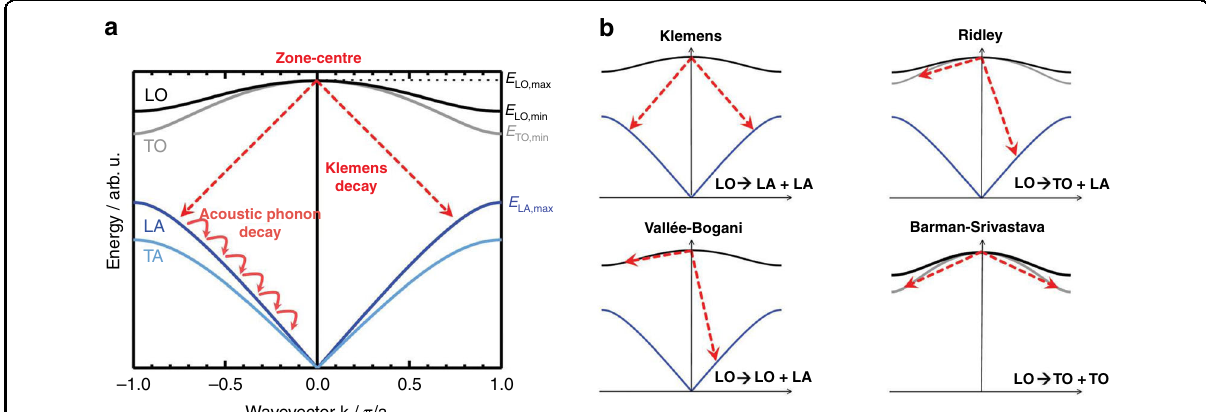
Fig. 6 The dispersion relation for a phonon in the case of diatomic materials in 3D form. a The predominant routes of phonon decay start from their origin center as LO phonons and progressively turn into lower energy acoustic phonons that are responsible for the dissipation of heat. b The four types of decay mechanisms are depicted as Klemens, Ridely, Vallee – Bogani, and Barman – Sirvastava. The fi gures are taken with permission from ref. 13